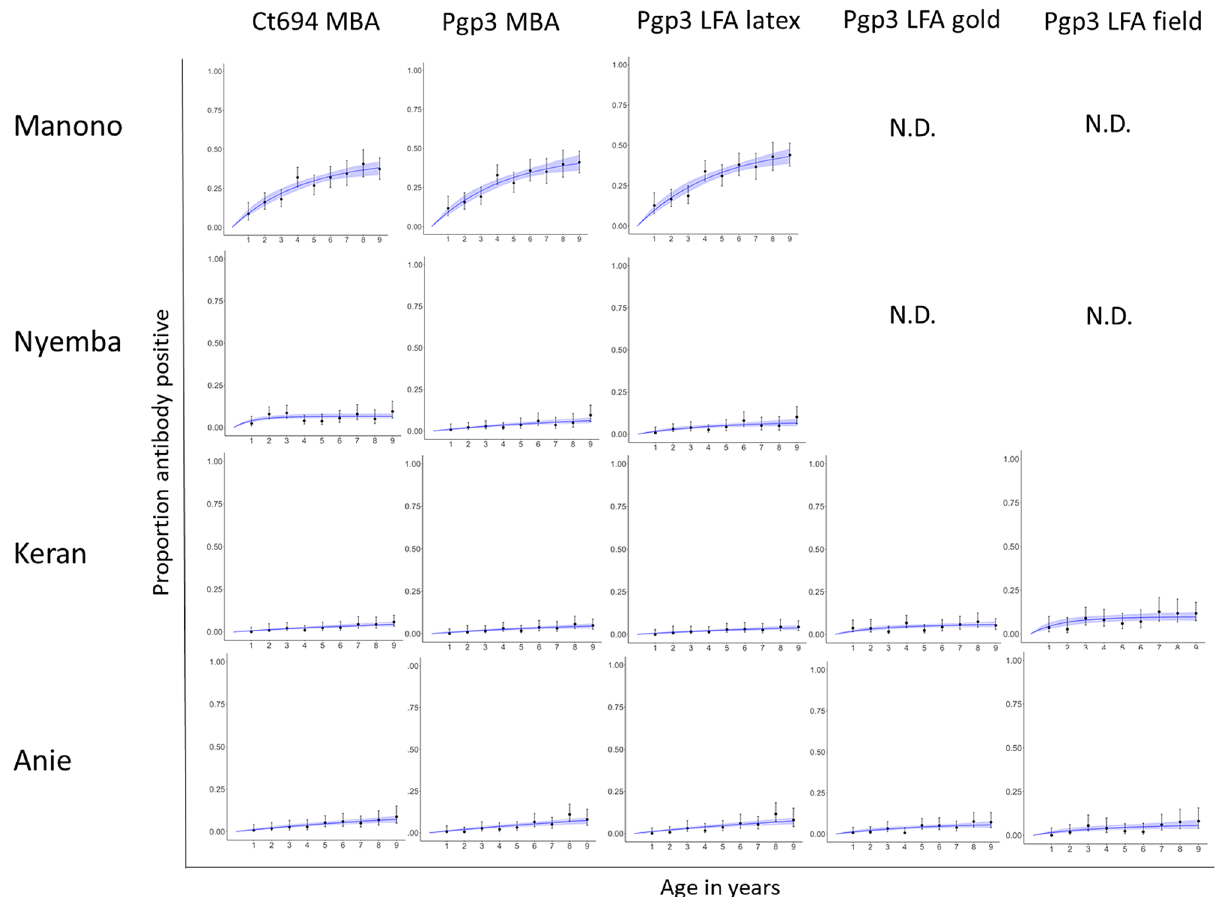
Figure 3. Proportion antibody positive by age in each participating evaluation unit. Manono health zone, Democratic Republic of the Congo (DRC); Nyemba health zone, DRC; Keran district, Togo; Anie district, Togo.